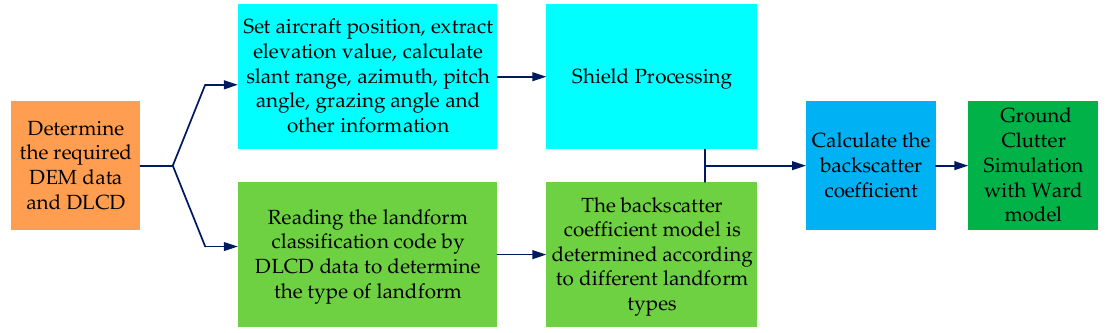
Figure 3. Flow chart of high-fidelity inhomogeneous ground clutter simulation.